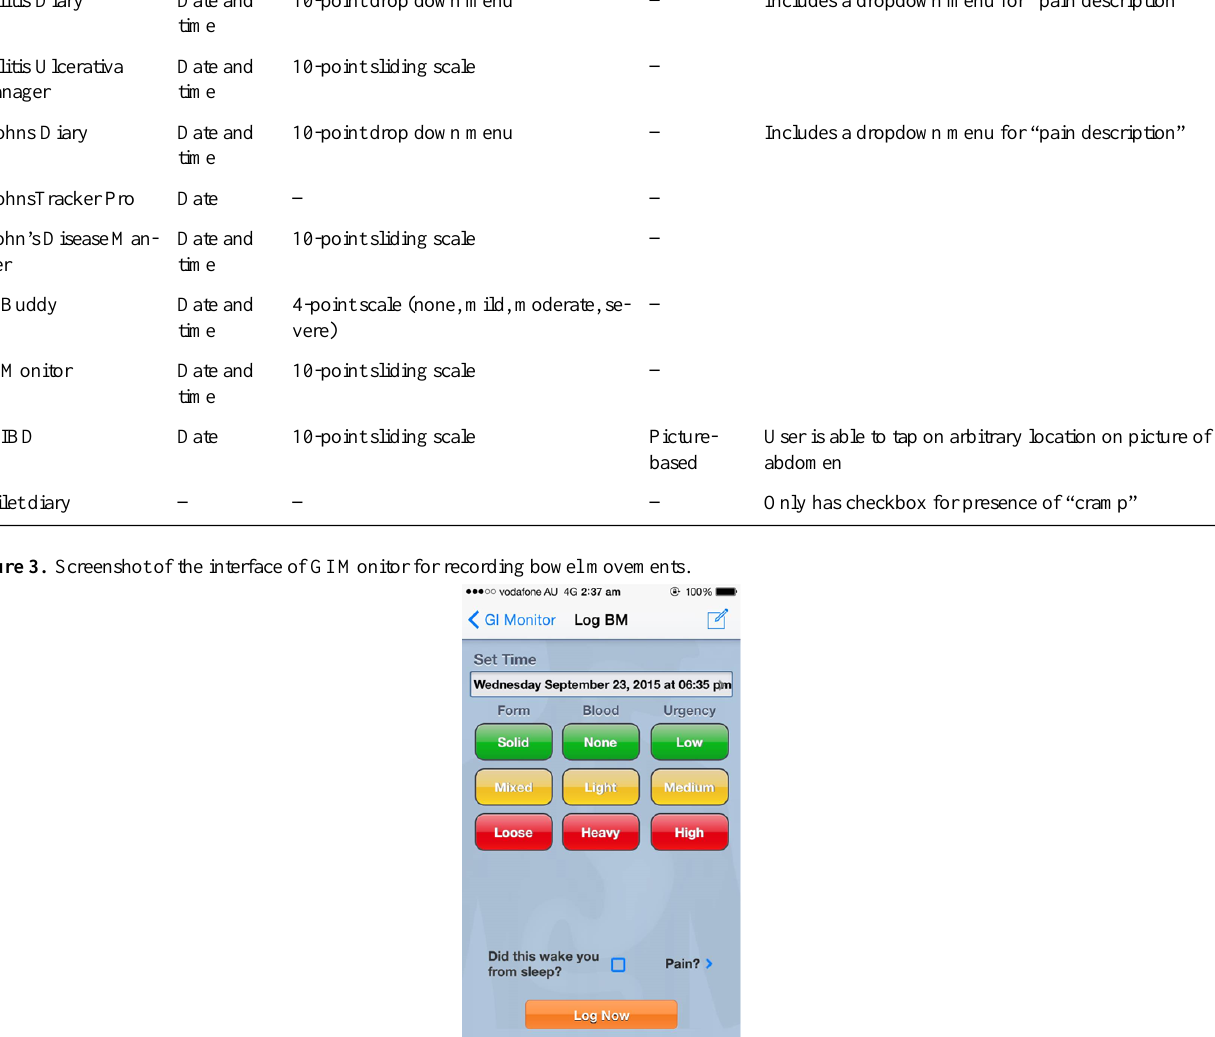
Table 6. Apps offering pain tracking. LocationSeverityTime